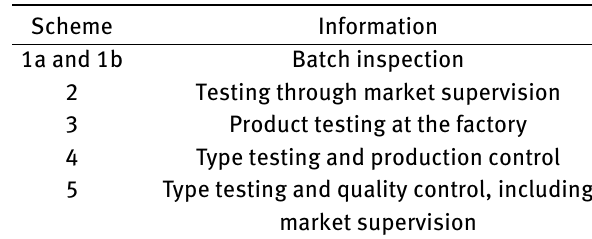
Table 2: Certification product